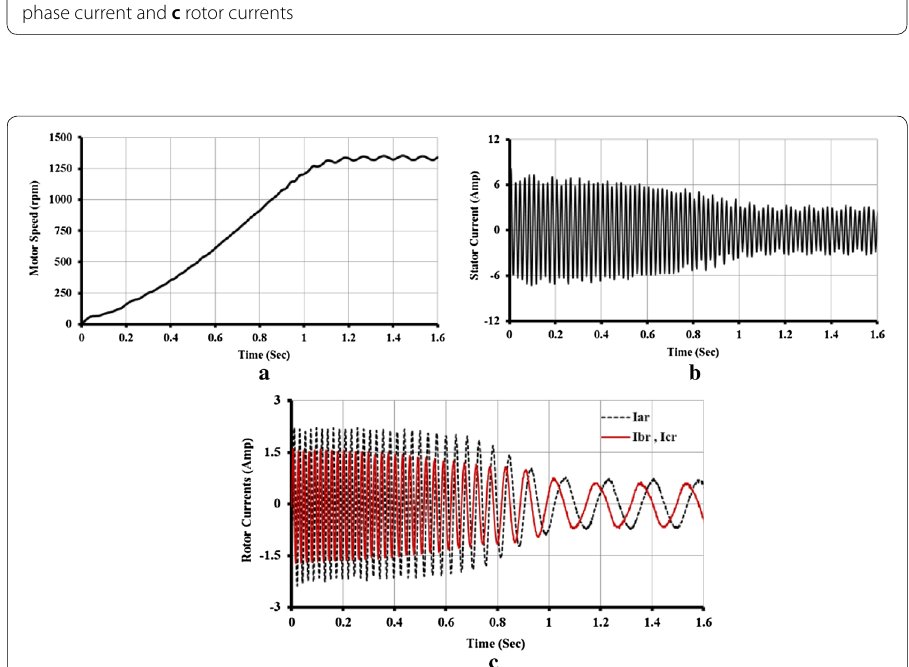
Fig. 10 Experimental results for delta with reversed one phase and external open circuit rotor windings connection, a motor speed, b stator phase current and c rotor